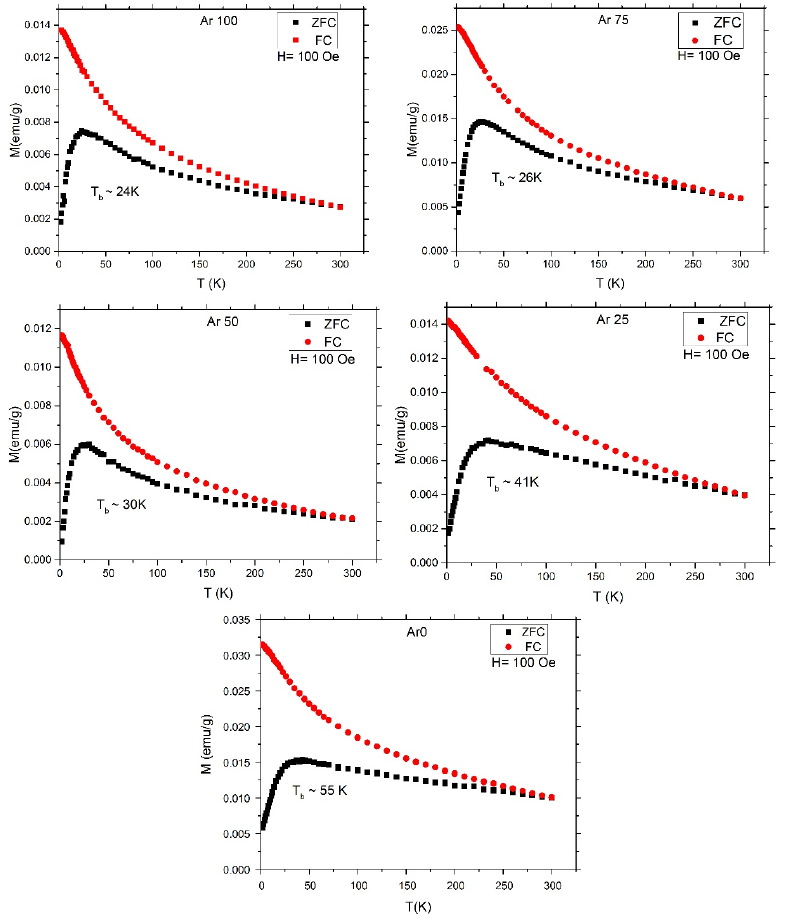
Figure 7. Zero ‐ field ‐ cooled and ( H = 100 Oe) field ‐ cooled magnetization curves of samples: Ar100, Ar75, Ar50, Ar25 and Ar0.